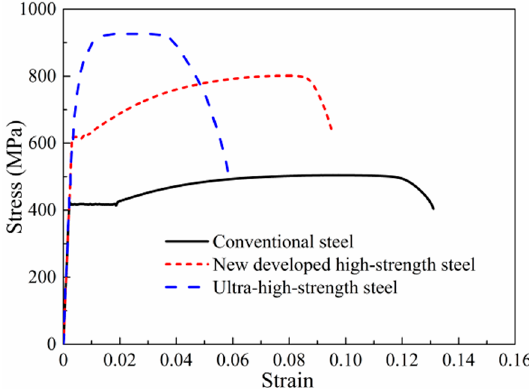
ff erent reinforcing